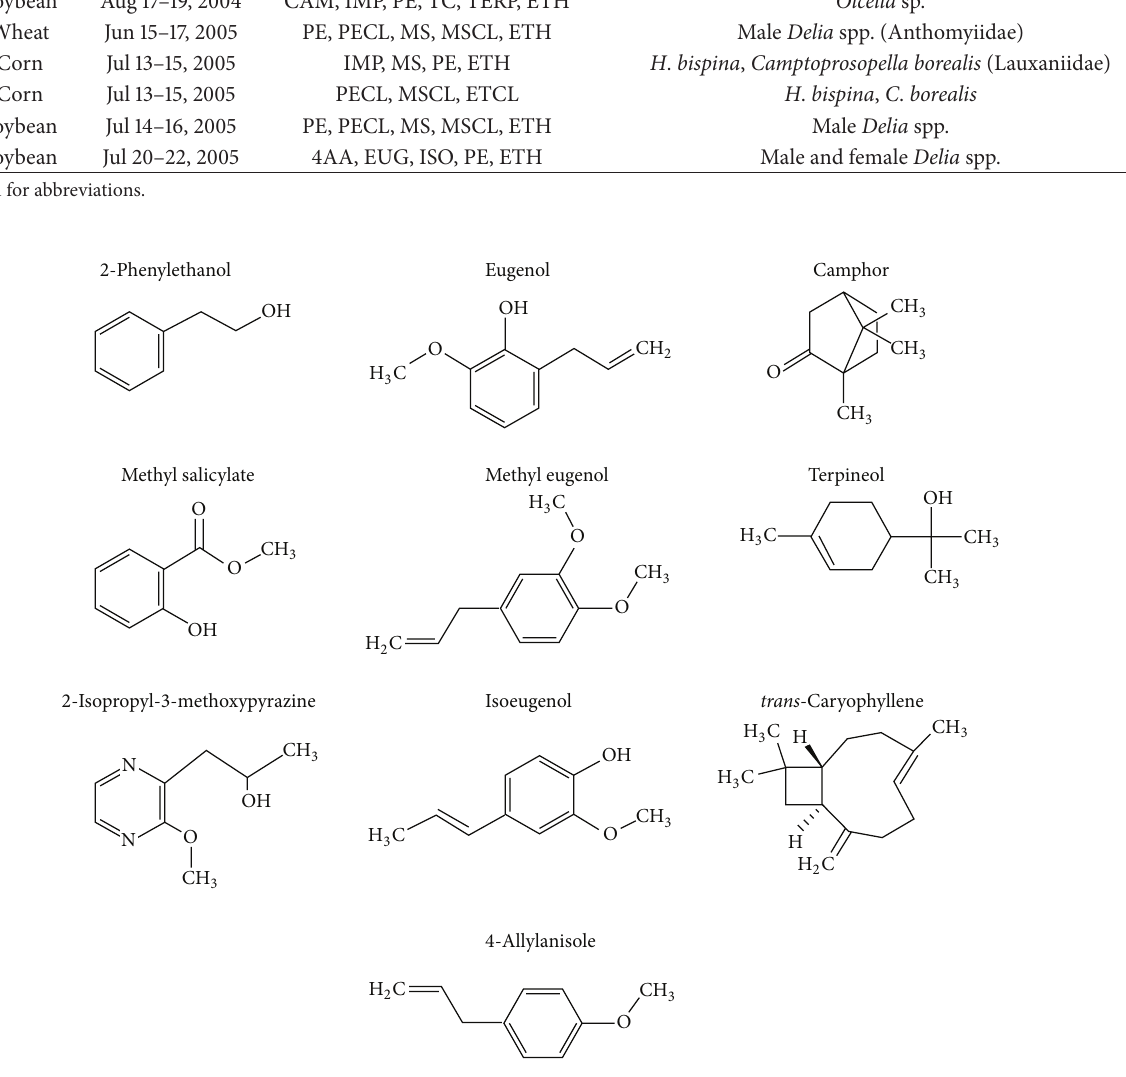
Figure 1: Chemical structures of test